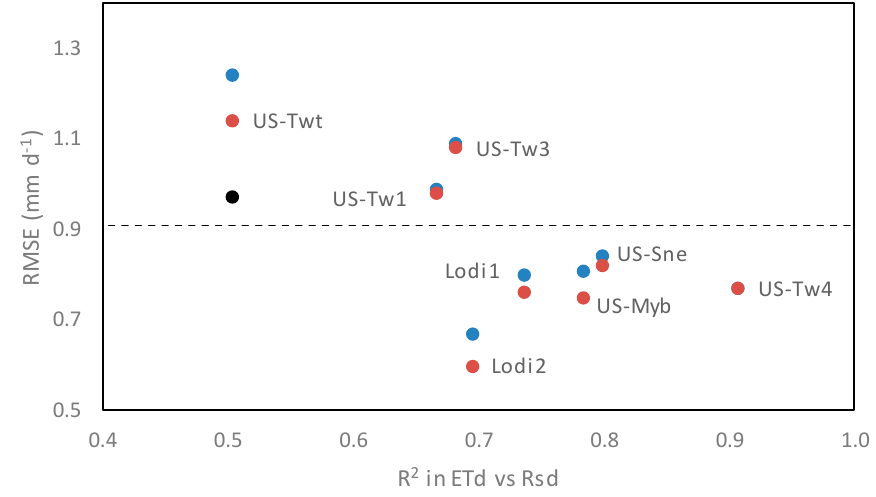
Figure 11. Root mean square error (RMSE) in daily ET retrievals using the CFSR (blue dots) and SSEC (red dots) inputs vs. the R 2 value computed between daily solar radiation and ET (unclosed) observed at the tower sites. The dotted line indicates the RMSE obtained with all sites combined. Also shown is the RMSE at US-Twt from a fusion experiment including the Landsat ET retrieval on DOY 171 in 2016 (black dot), omitted from the standard run due to extensive cloud cover in the southern part of the modeling domain.